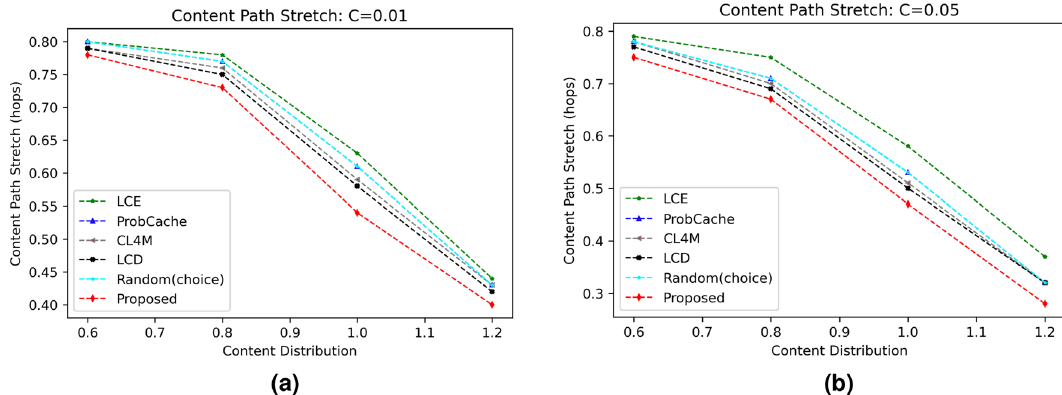
Figure 7. Influence of content distribution (α) on CPS.